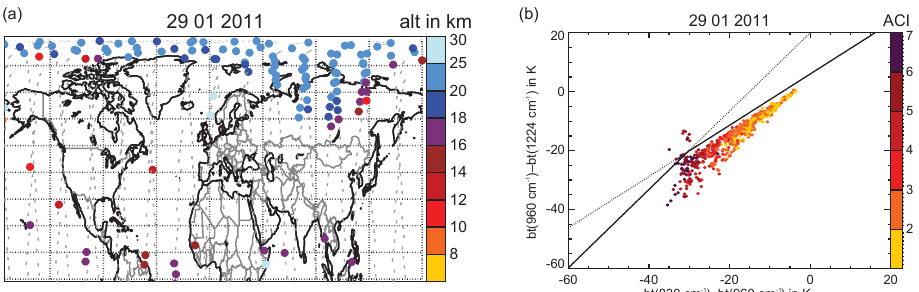
Figure A8. Detection of non-ice particles on 29 January 2011. (a) Location and altitudes of the particle detections. (b) Same as Fig. 5d but for 0–60 ◦